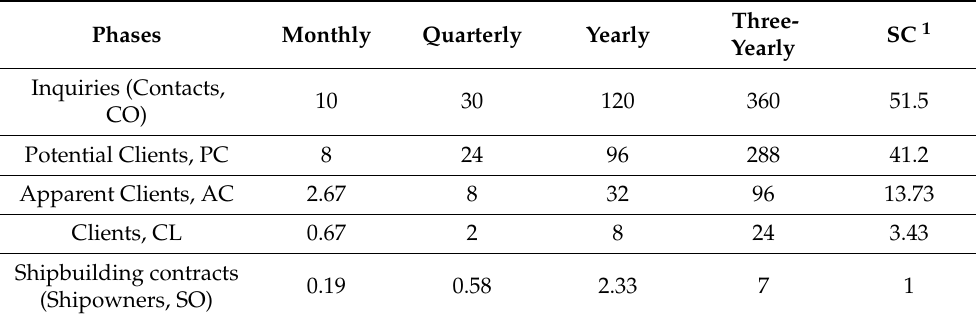
Table A1. The average number of the “shipyard—customer” interactions by conversion phases—the current